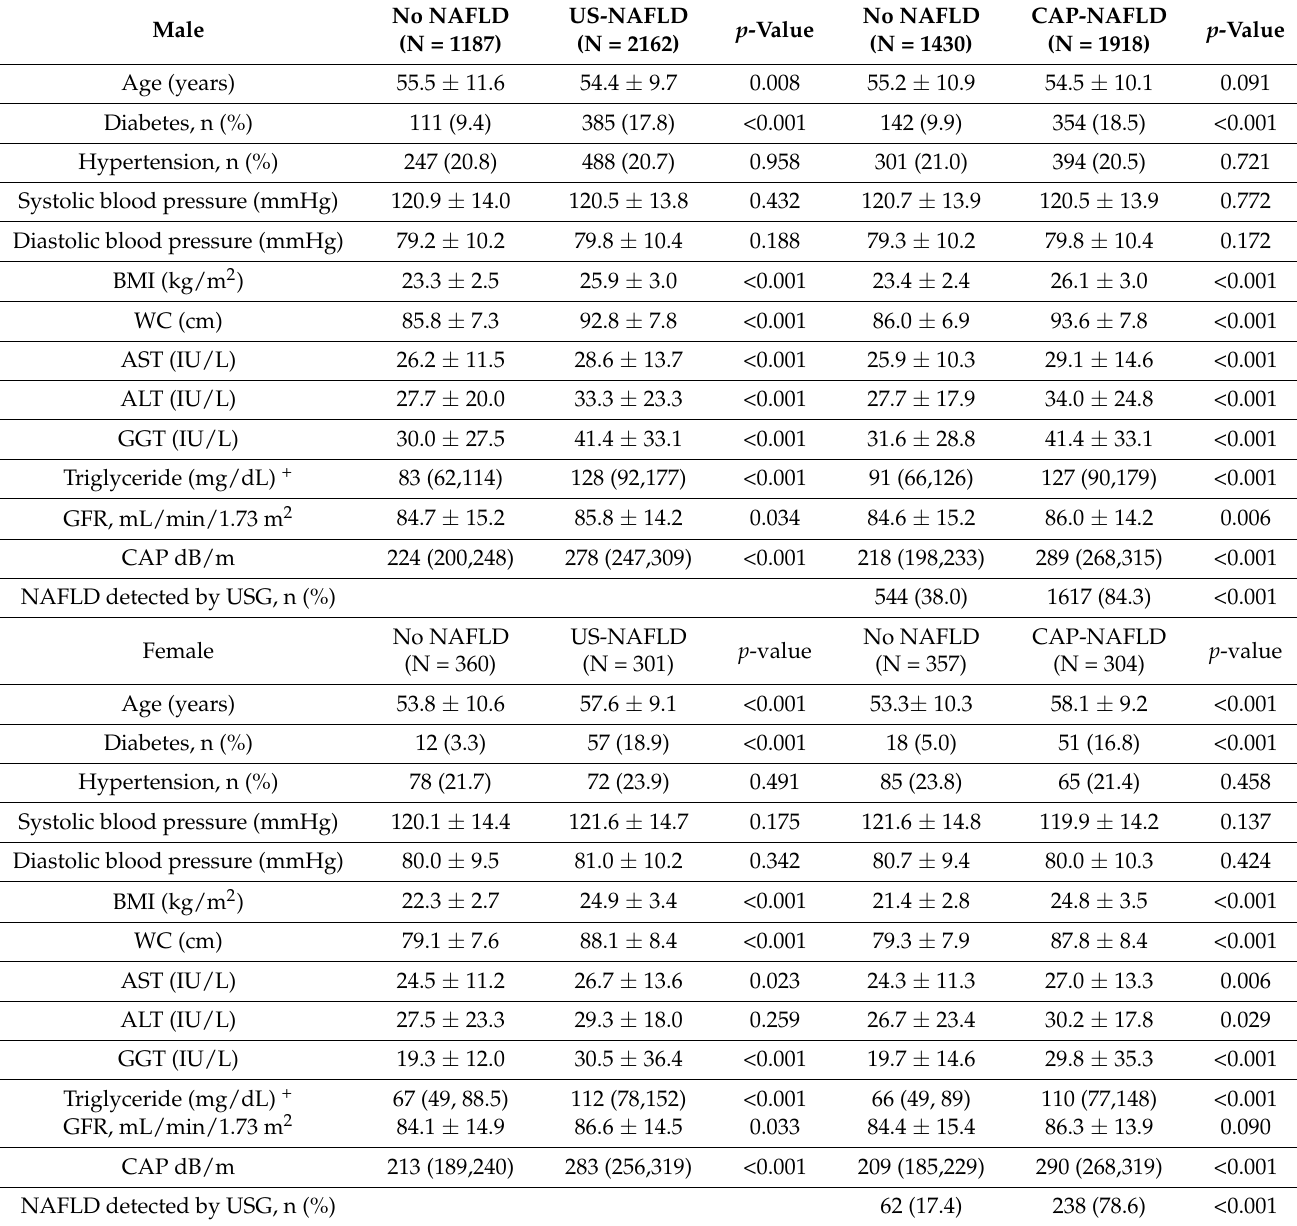
Table 1. Baseline characteristics of the study population stratified by